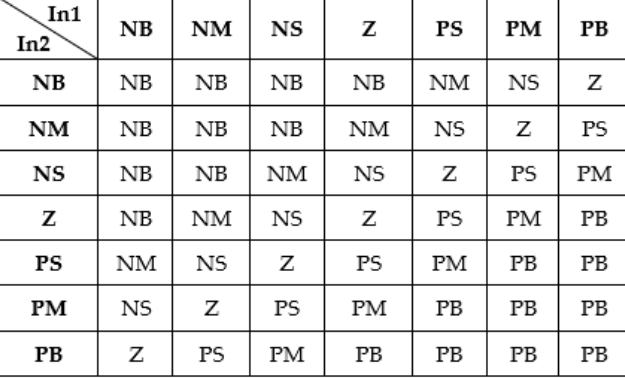
Figure 11. The inference rules for the “SpeedFIS”.